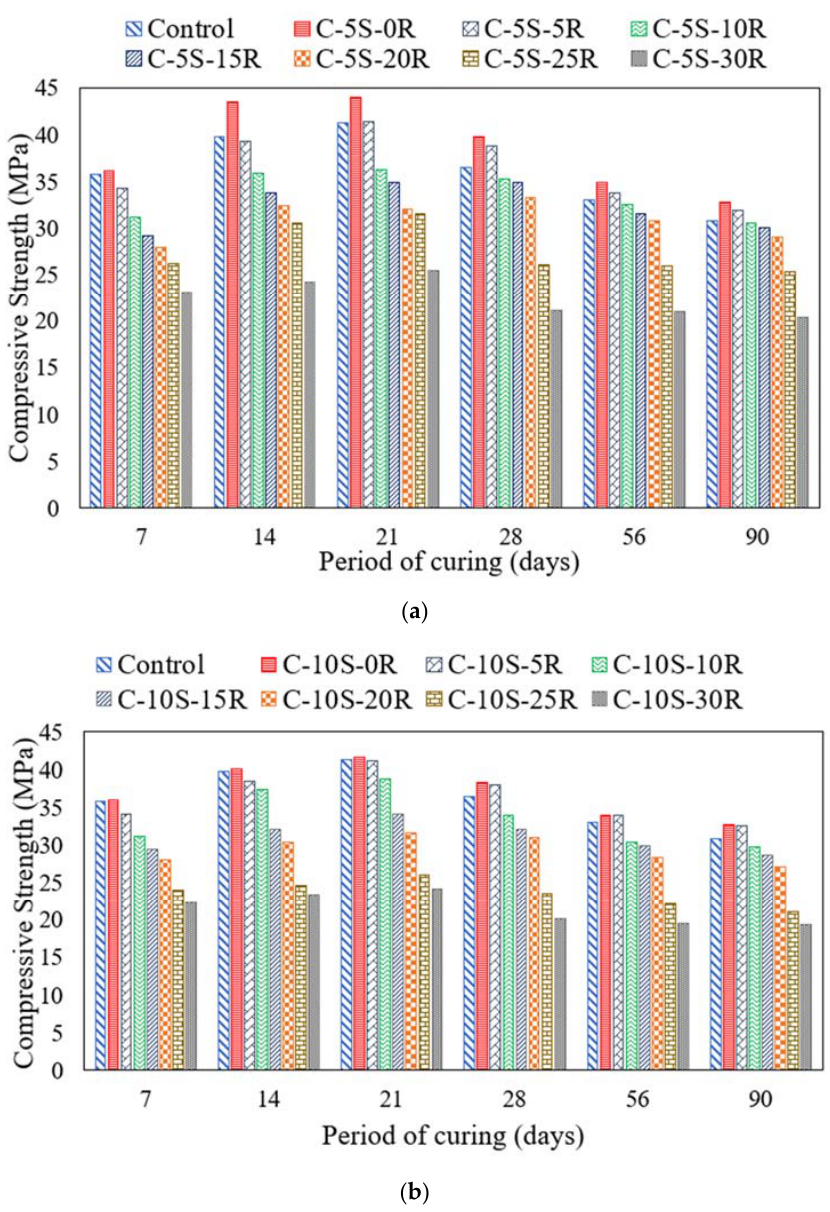
Figure 8. ASR effects on Compressive Strength incorporating various proportions of SF and